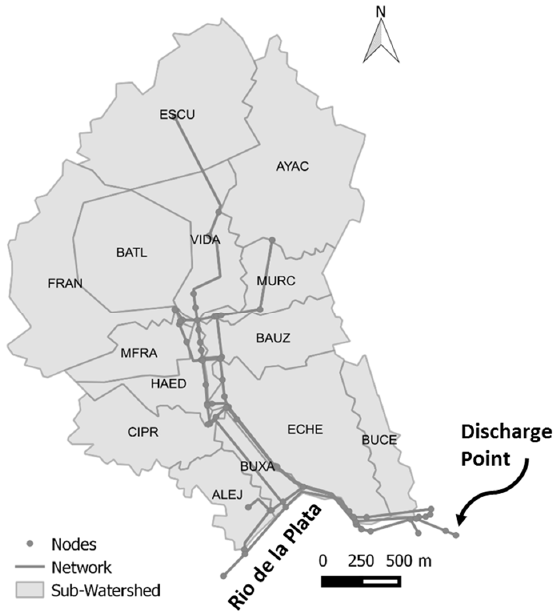
Figure 4. Watershed, subwatersheds, and discharge point.